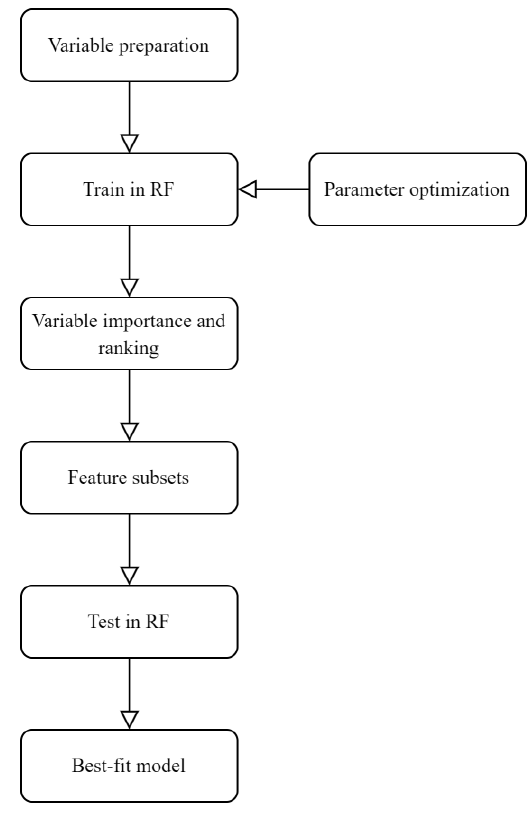
Figure 2. Flow chart of the main steps of the